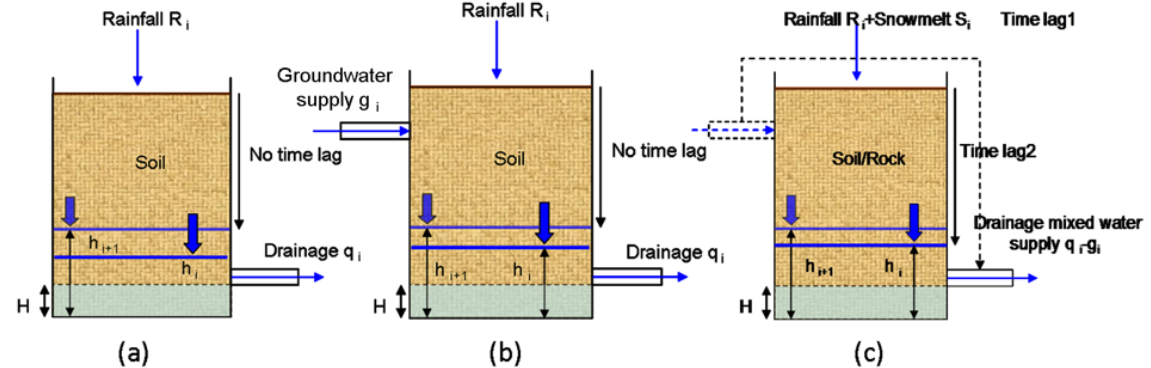
Figure 5. Design of the modified tank model. (a) Original tank model considering the vertical infiltration and drainage affecting the water table. (b) Improved model considering both vertical infiltration and horizontal water flow. (c) Modified tank model including water supply and two time lags (snowmelt and